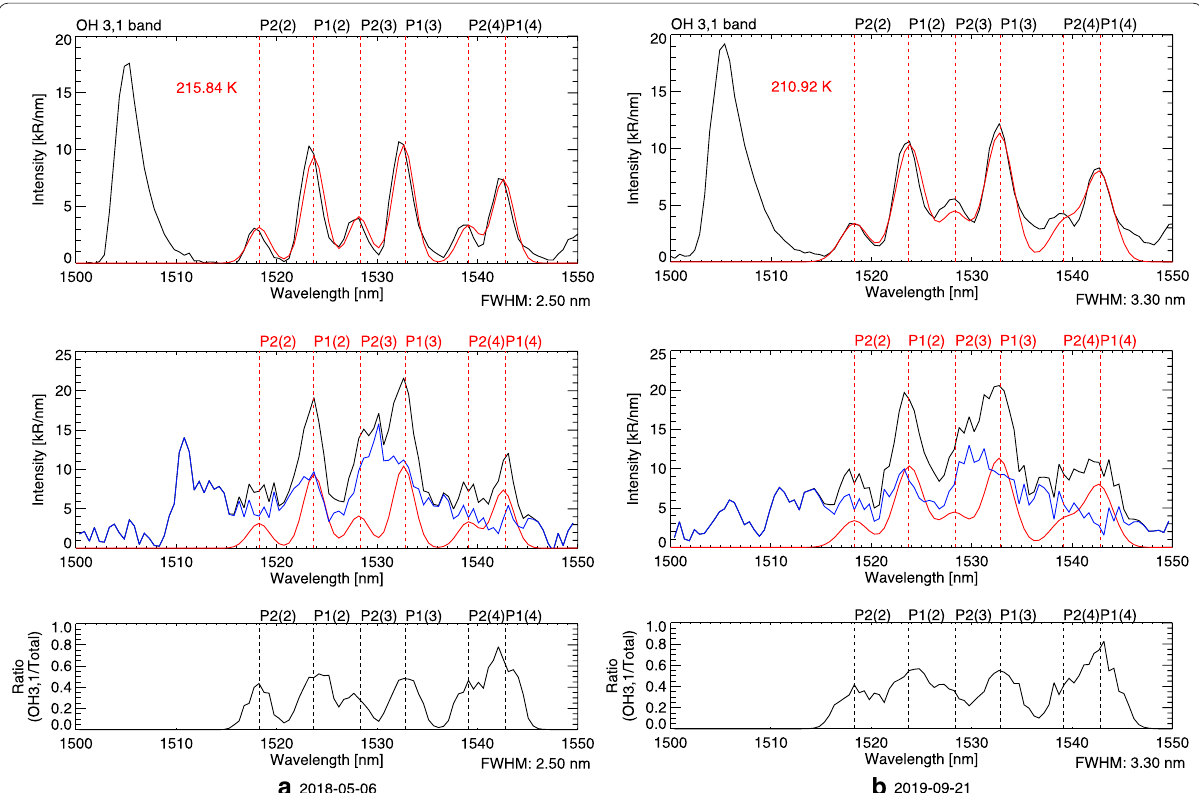
Fig. 8 Summary plots for evaluating N + 2 Meinel (1,2) auroral contaminations to OH (3,1) band measurements based on spectral data a at Syowa station, on May 6, 2018 and b at Kiruna on September 21, 2019. (Top) The nightly mean spectrum (black) and artificial spectrum (red) that are created from convolutions of OH (3,1) band spectrum ( P 1 (2), P 1 (3), P 1 (4), P 2 (2), P 2 (3), and P 2 (4)) and instrumental functions. (Middle) Red and blue lines are the artificial OH airglow spectrum and the observed N + 2 Meinel (1,2) aurora spectrum, respectively. Synthetic spectrum are shown by black lines. (Bottom) Ratio between OH airglow intensity and total intensity (OH airglow and N + 2 Meinel (1,2)) as a function of